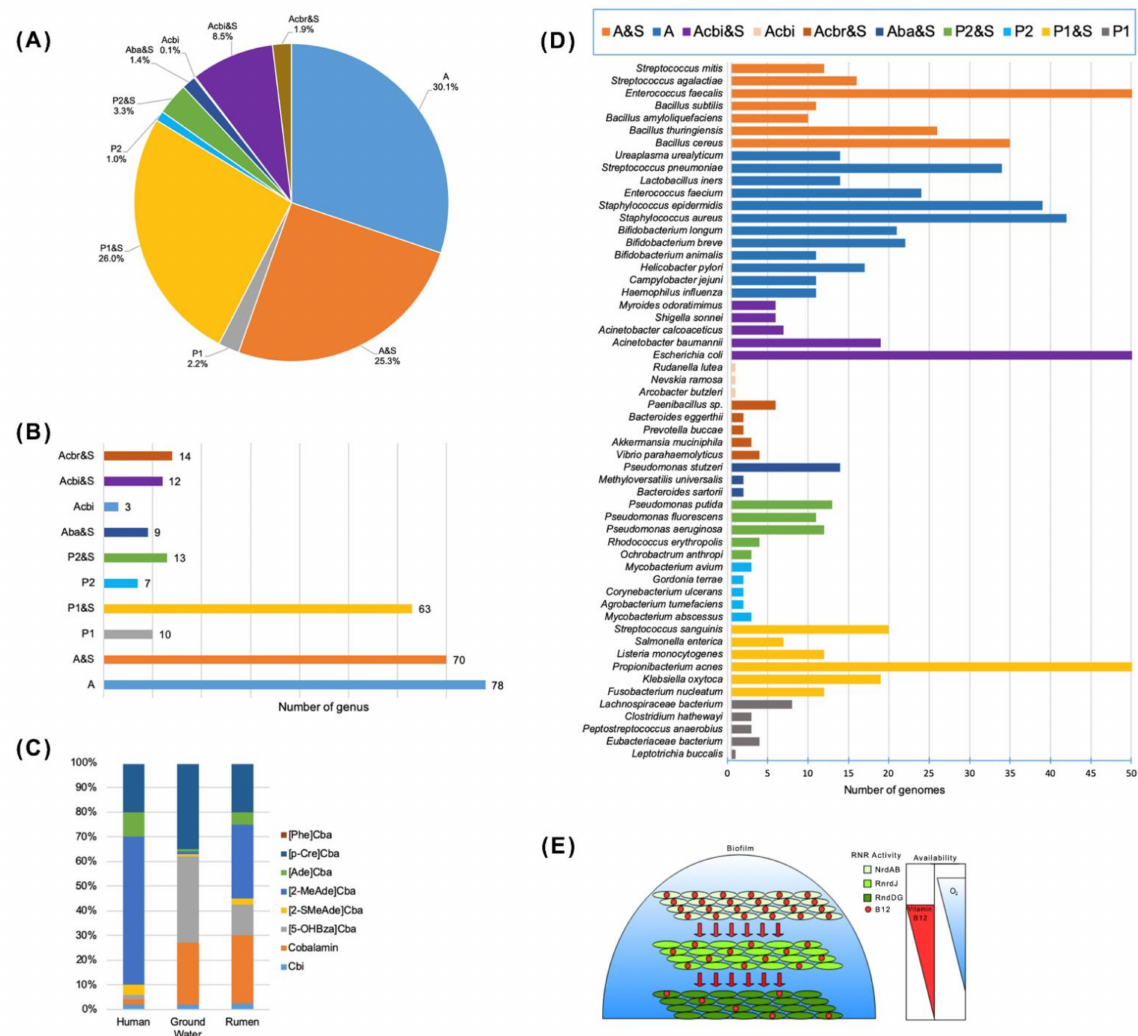
Figure 4. Distribution of microbial cobalamins (vitamin B12 family cofactors) biosynthesis capability in various ecosystems: ( A ) general distribution of the basic B12-related pathway variants among publicly available human gut microbial (HGM) genomes, according to Rodionov et al. [12]: P1 and P2 - de novo anaerobic and aerobic Cbl biosynthesis (protothrophy), respectively; P1&S and P2&S - de novo anaerobic and aerobic biosynthesis and salvage; Aba&S -cobyrinate auxotrophy and salvage; Acbr&S - cobyrinate diamide auxotrophy and salvage; Acbi&S -cobinamide auxotrophy and salvage; A&S -cobalamin/B12